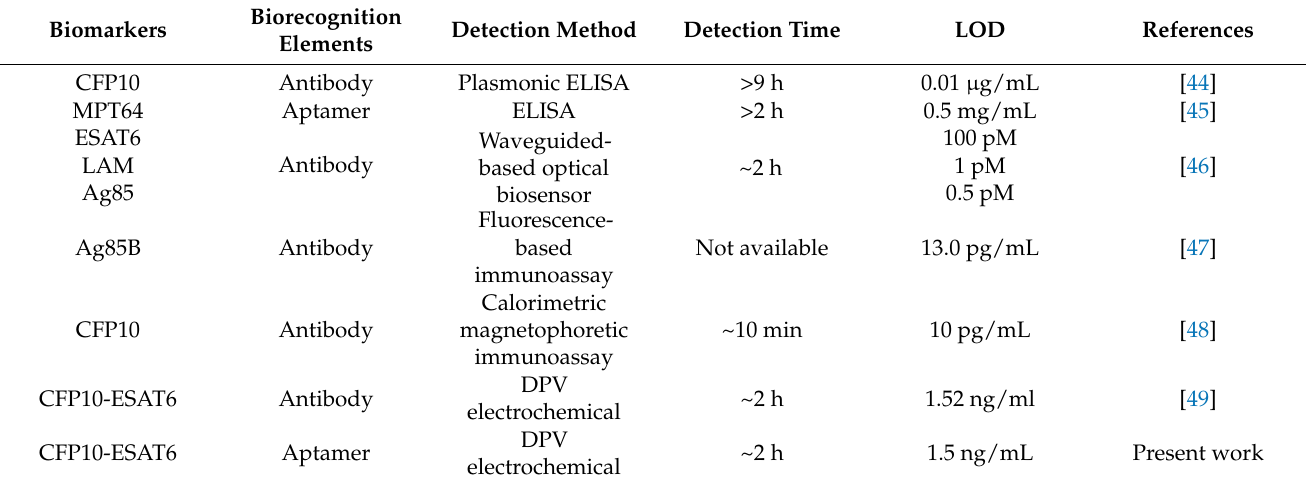
Table 1. Limit of detection (LOD) of different detection method for M. tuberculosis